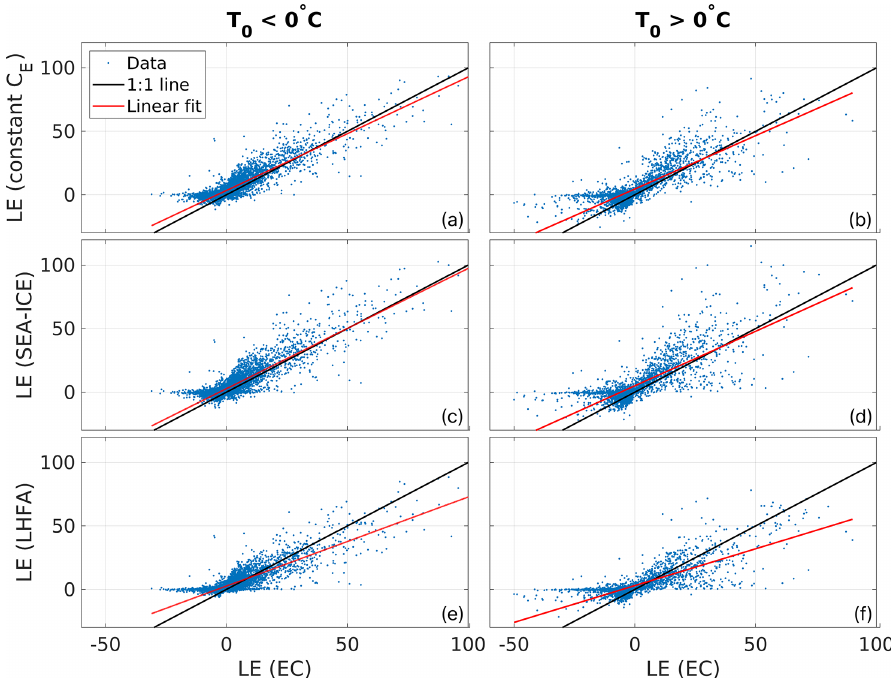
Figure 8. Scatter plots of the three included models against latent heat flux EC measurements. Black line indicates a 1 : 1 fit and red line the best linear fit. All the axes have a unit of Wm − 2 . Linear fit parameters are listed in Table 3. Table 3. Linear fit parameters ( ax + b ) and statistics of 30min LE values between EC and model data. Slope a Offset b Standard deviation CRMSE Correlation (Wm − 2